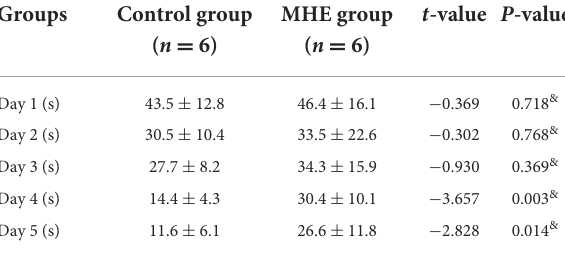
TABLE 2 MWM results of control and MHE